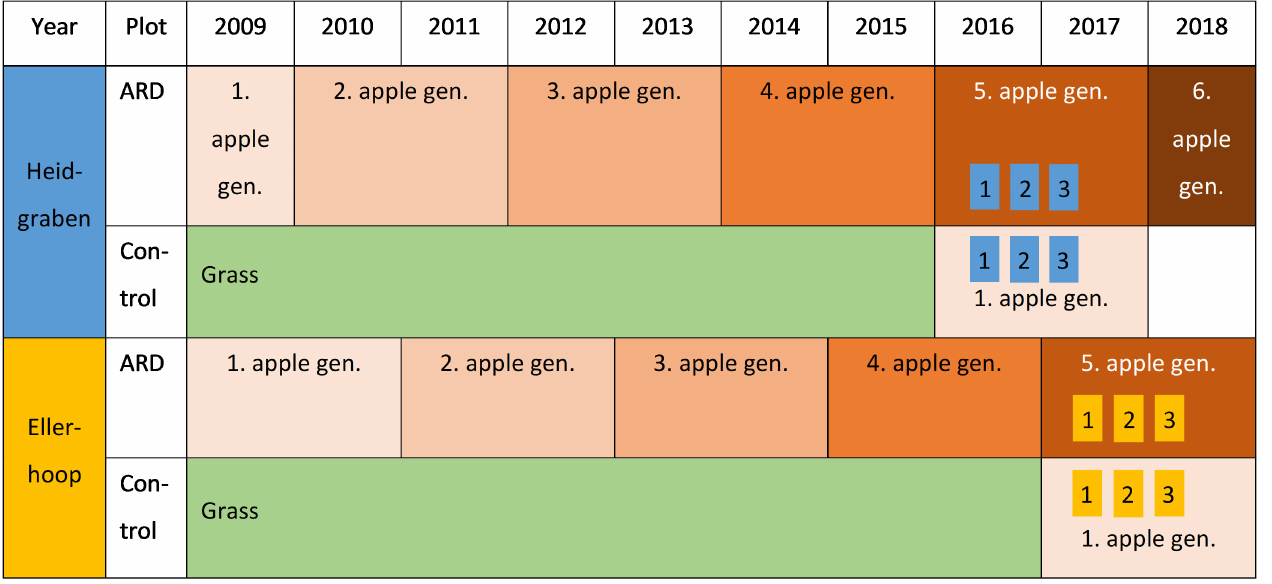
Frontiers in Microbiology |